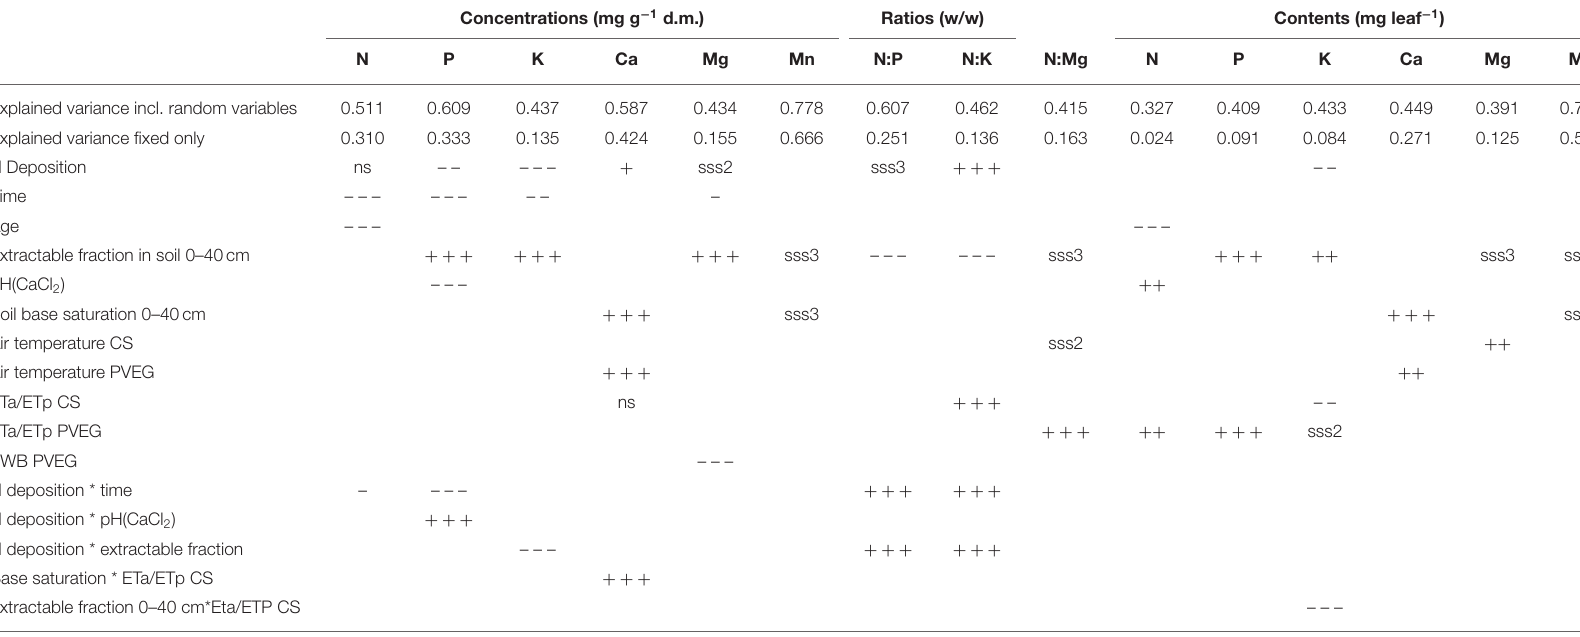
TABLE 1 | Associations between element concentrations, ratios, and contents in foliage of Fagus sylvatica and different predictor variables. Concentrations (mg g − 1